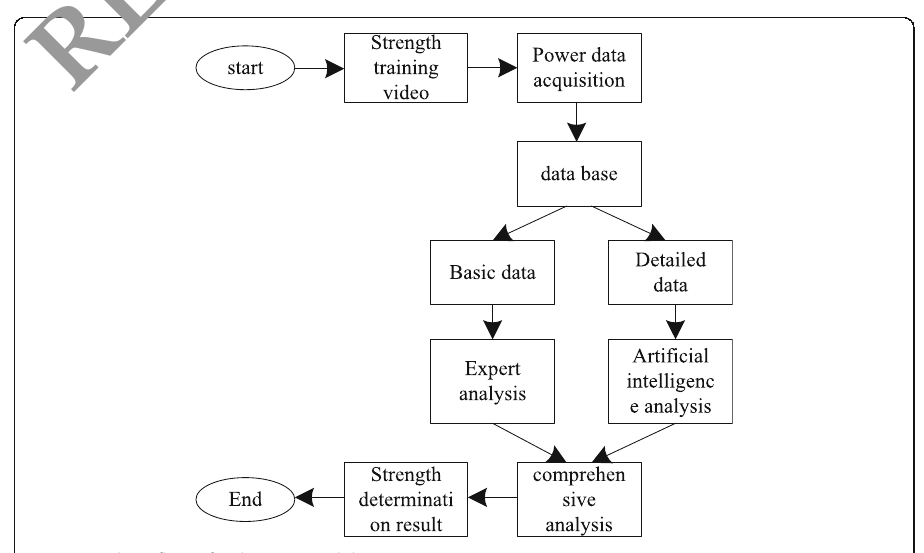
Fig. 6 Working flow of judgment